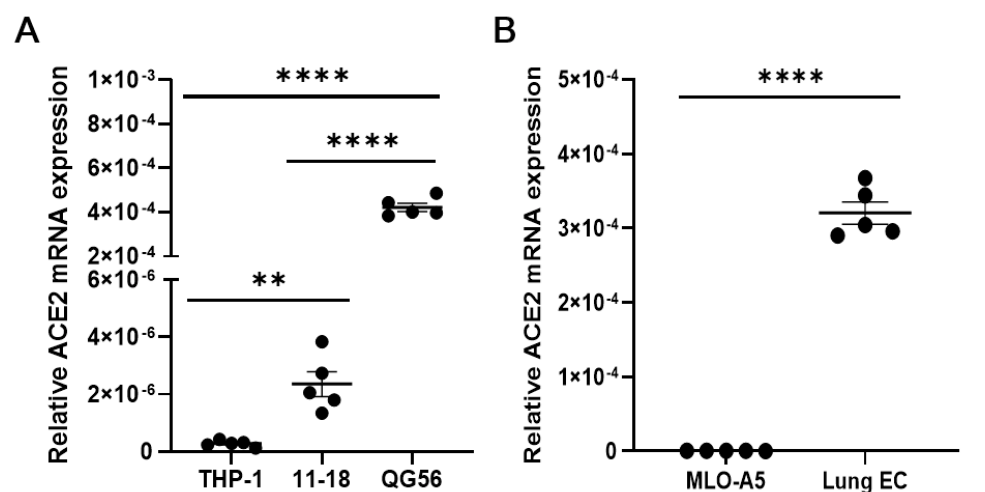
Figure 6. qRT-PCR measuring the expression of ACE2 in human ( A ) and mouse ( B ) cells. Relative expression of ACE2 to β -actin was determined by using the 2 - Δ CT method. In panel A, statistical significance between two groups (THP-1 vs. 11-18) was analyzed by a two-tailed unpaired t -test, while other comparisons were by one-way ANOVA. Results are shown as column scatterplots overlayed with the mean ± SEM of at least 3 independent experiments, in which each sample was triplicated. ** p < 0.01; and **** p < 0.0001.